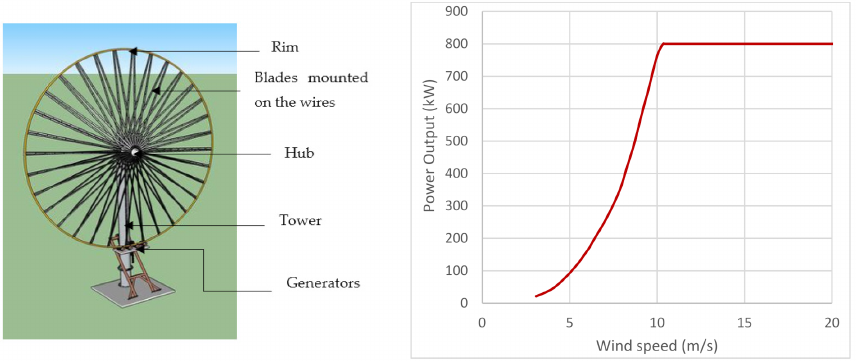
Figure 2. ( left ) Current design and ( right ) the power curve of the BWT [32] reproduced by